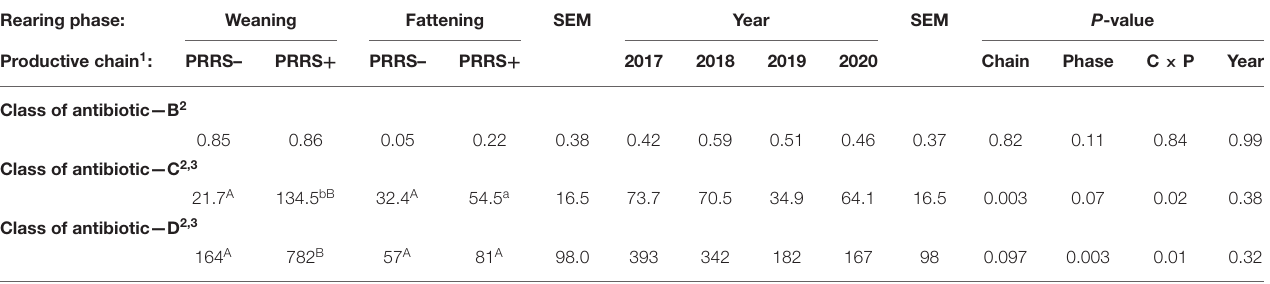
TABLE 2 | Consumption of antibiotics in the pig production chain differentiated by the occurrence of porcine reproductive and respiratory syndrome (expressed as mg of active compound per total kg of meat produced). Rearing phase: Weaning Fattening SEM Year SEM P -value PRRS +